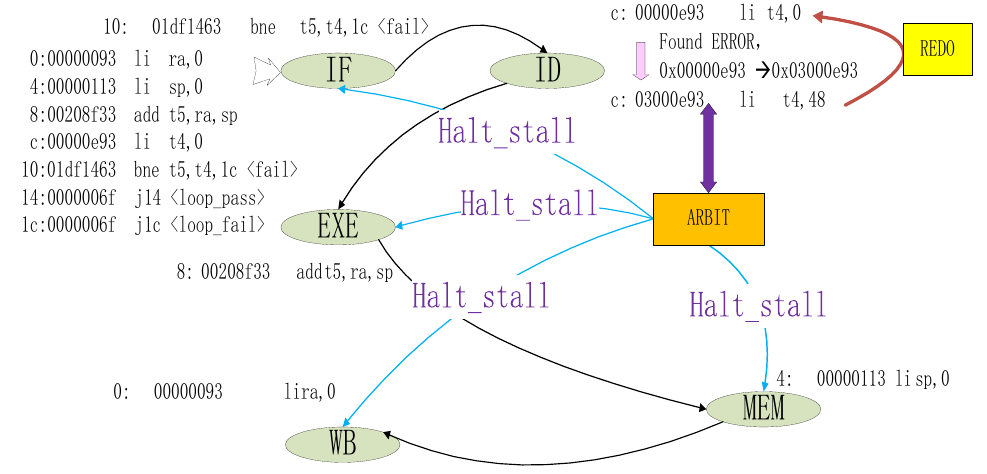
Figure 19. Program operation abnormal data flow 1.